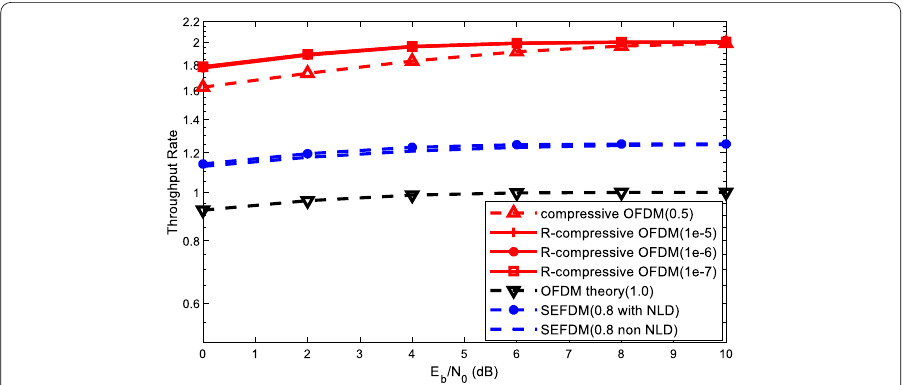
Fig. 9 ThroughputRate of compressive OFDM with different regularization parameters, OFDM and